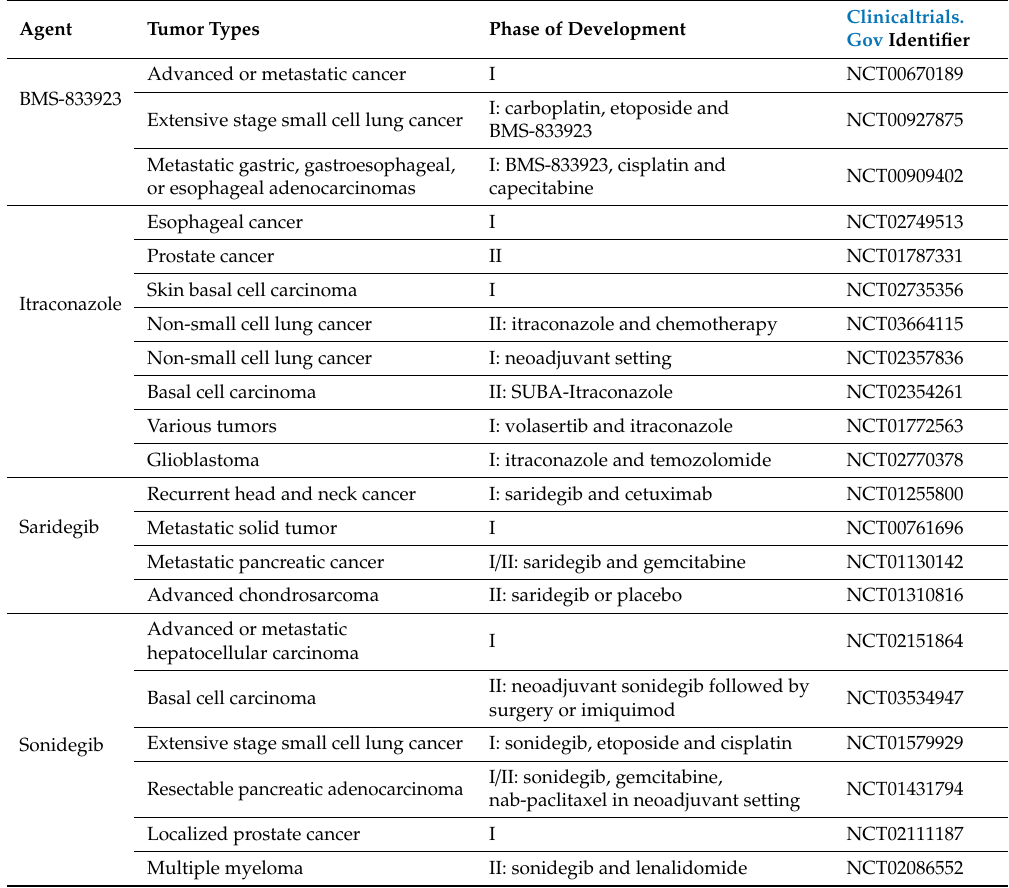
Table 2. Ongoing clinical trials evaluating agents targeting hedgehog signaling